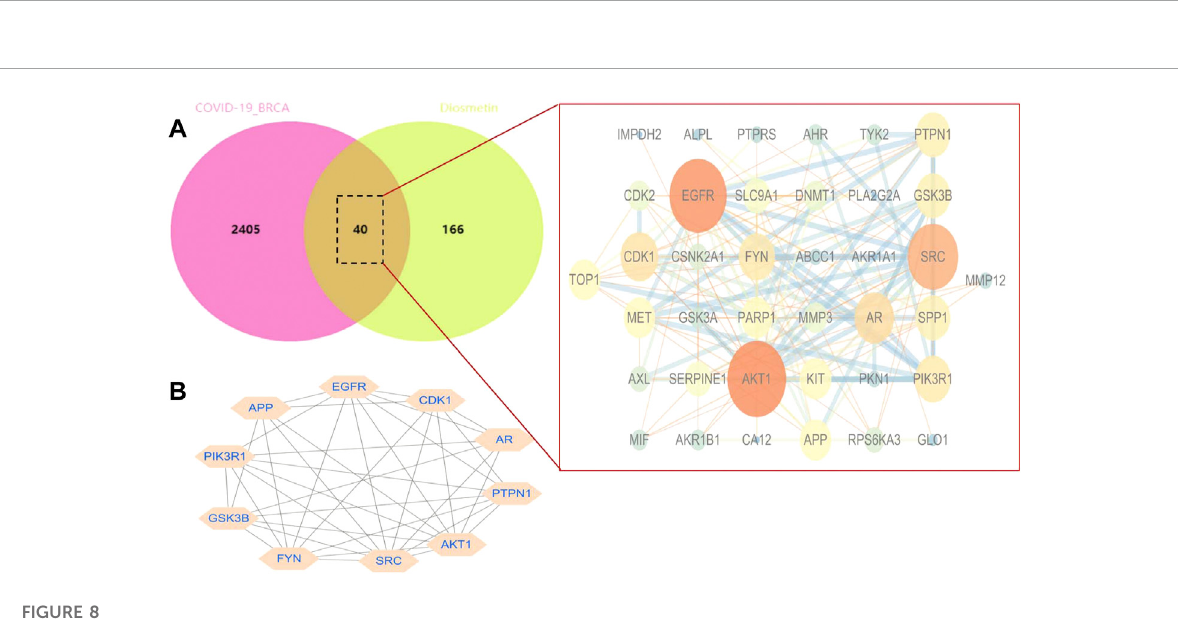
126. The docking results show that the amino acid residues of small molecules and protein receptors have hydrogen bonds and interactions at VLA-280 (3.0 Å) and SER-436 (3.2 Å), and form